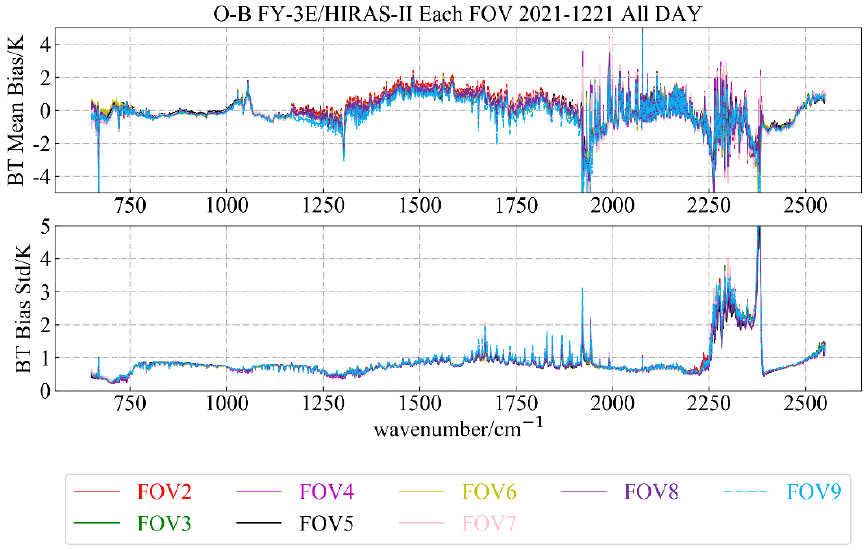
Figure 11. Mean bias of OMB and standard deviation of OMB between individual FOVs.